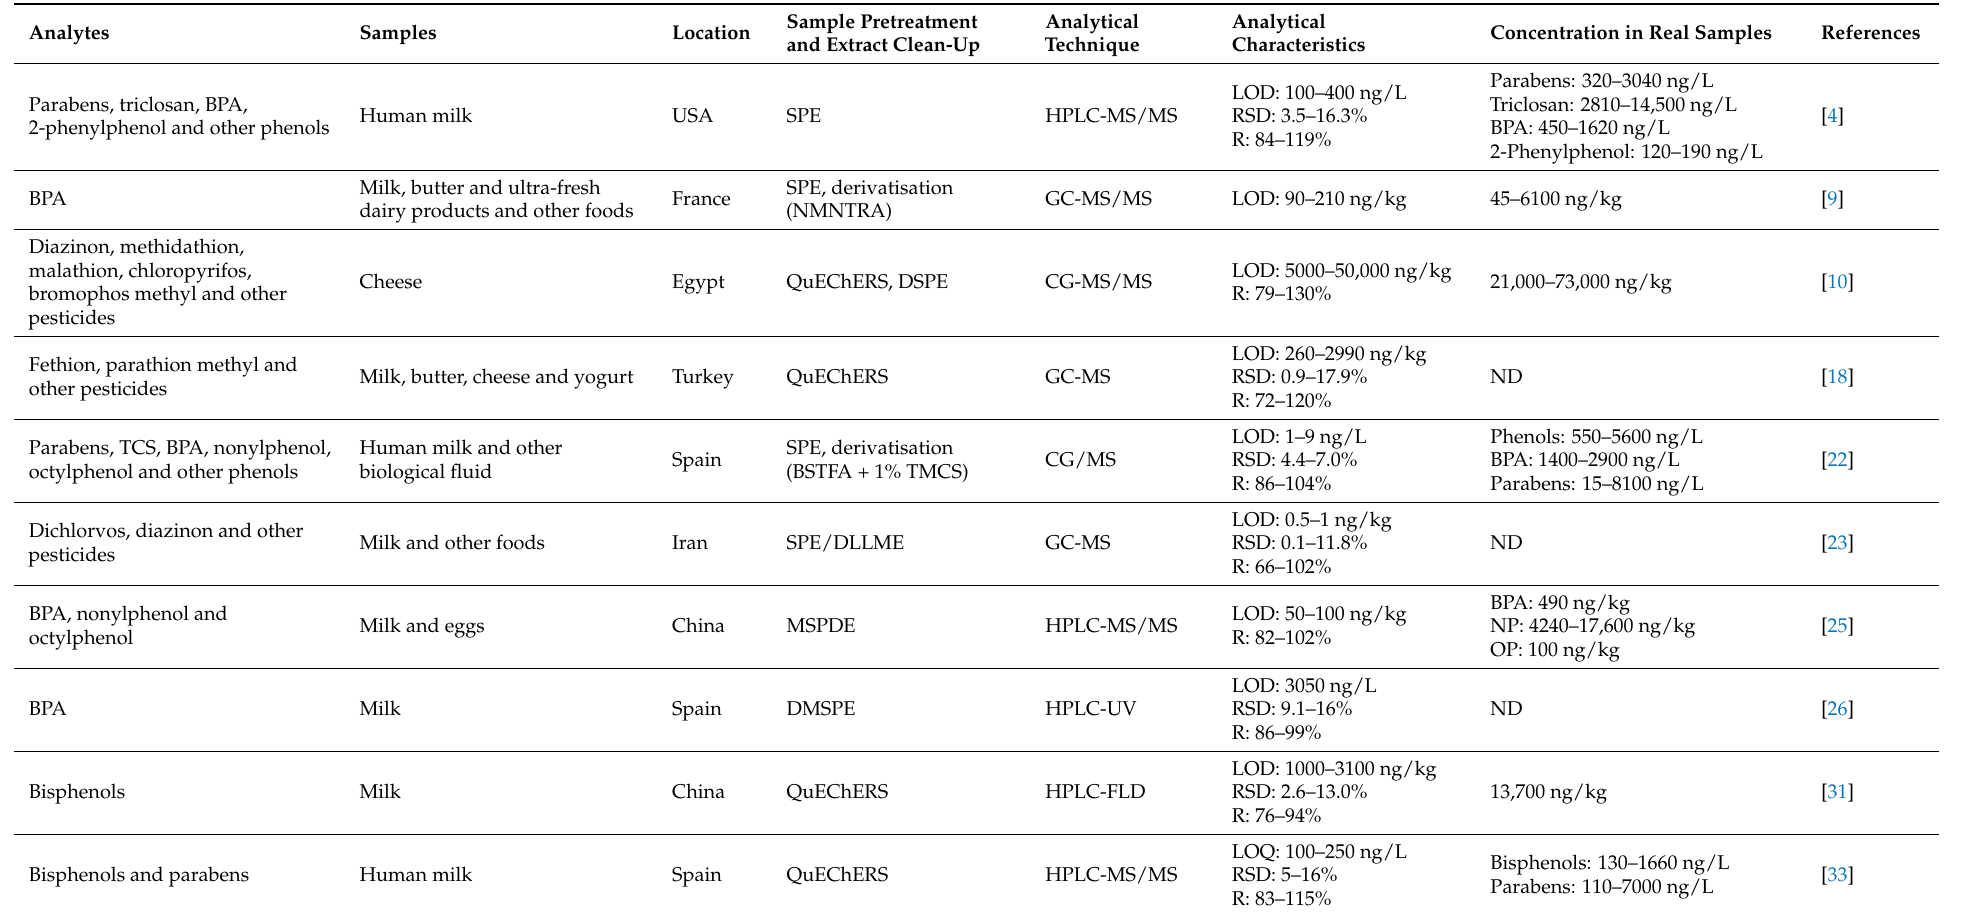
Table 5. Summary of studies reporting the presence of EDCs in dairy products a